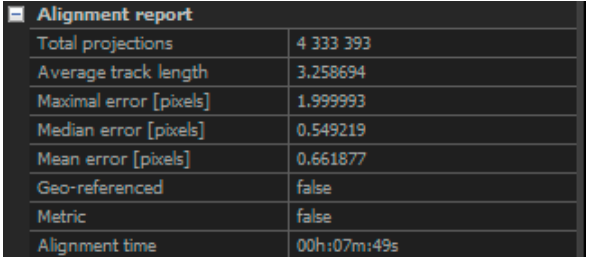
Figure A5. Alignment Report for Room 25 .